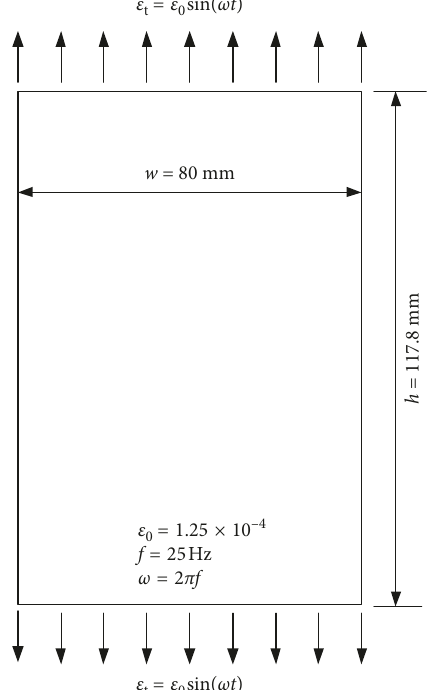
Figure 5: An uncracked plate subjected to imposed sinusoidal